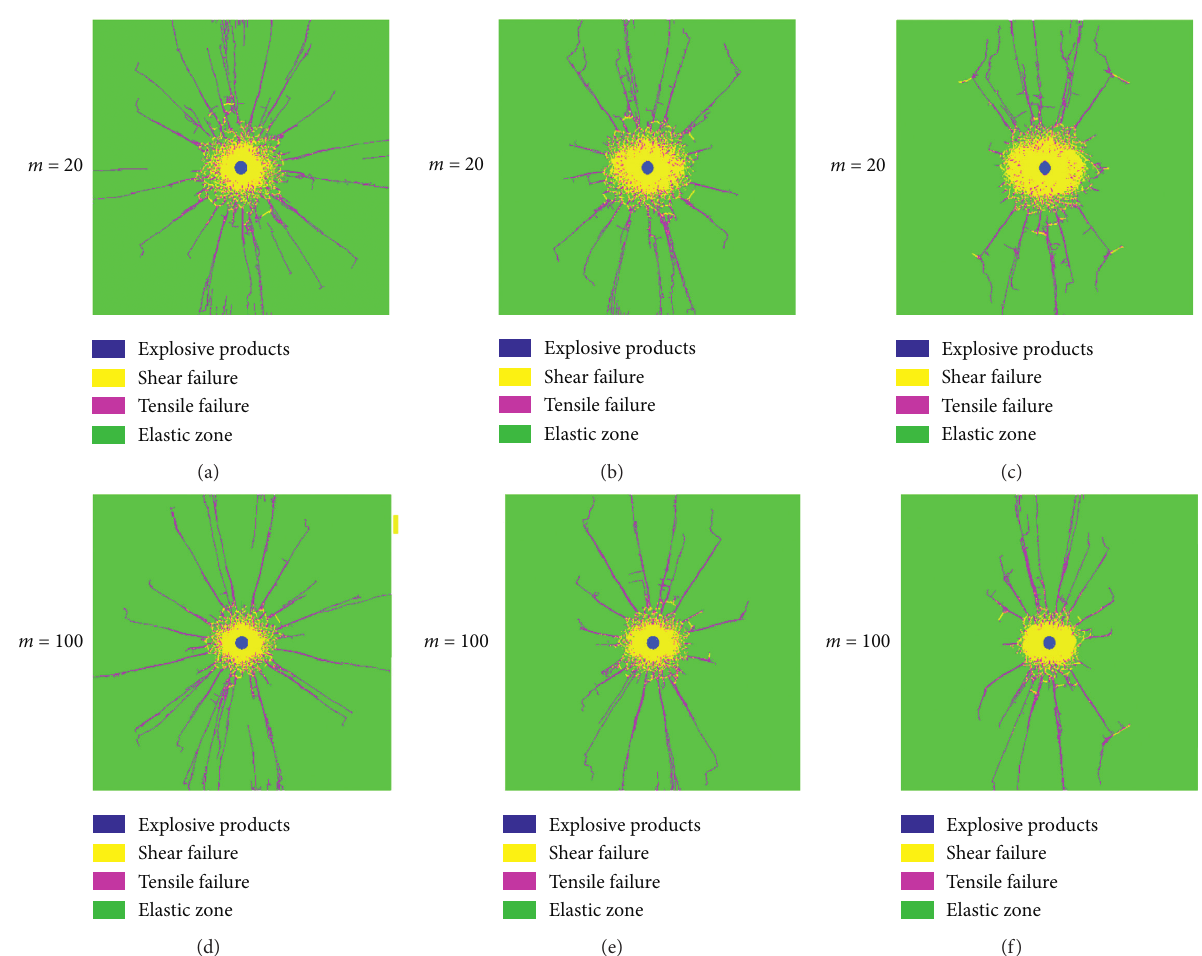
Figure 20: Comparison of blast-induced fractures under P